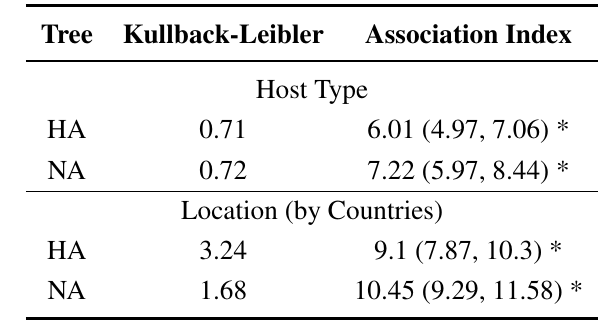
Table 2. Kullback-Leibler divergence and Association Index statistics assessing the fit of the viral data to the discrete phylodynamic